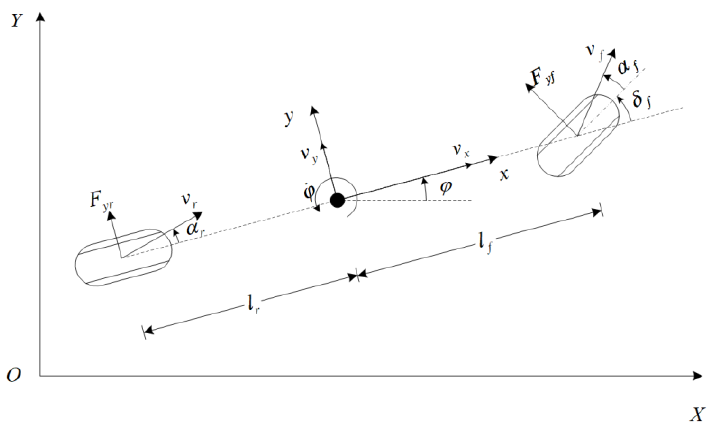
Figure 11. Bicycle model for trajectory tracking layer.